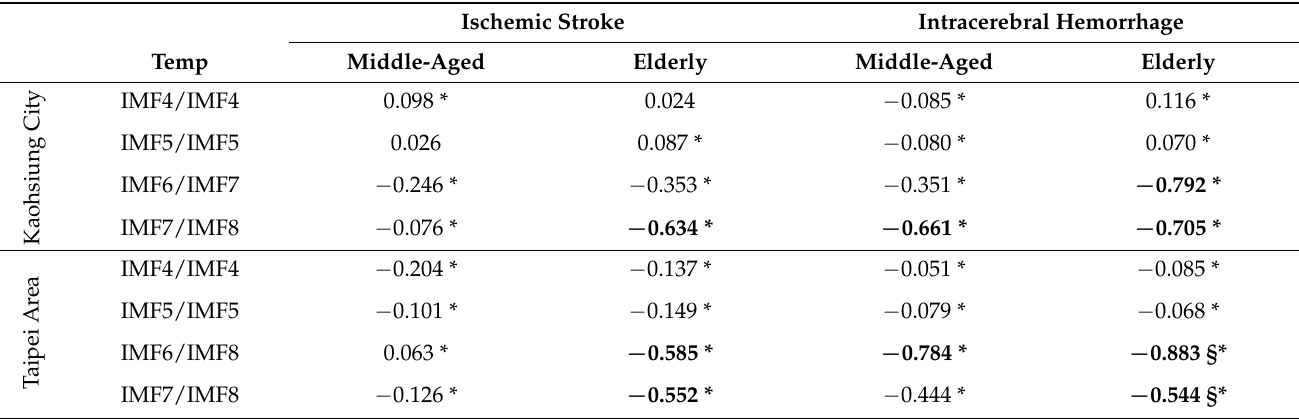
Table 4. Spearman’s rank correlation coefficients between the IMFs of temperature and the IMFs of stroke events with similar period intervals in Kaohsiung City and Taipei